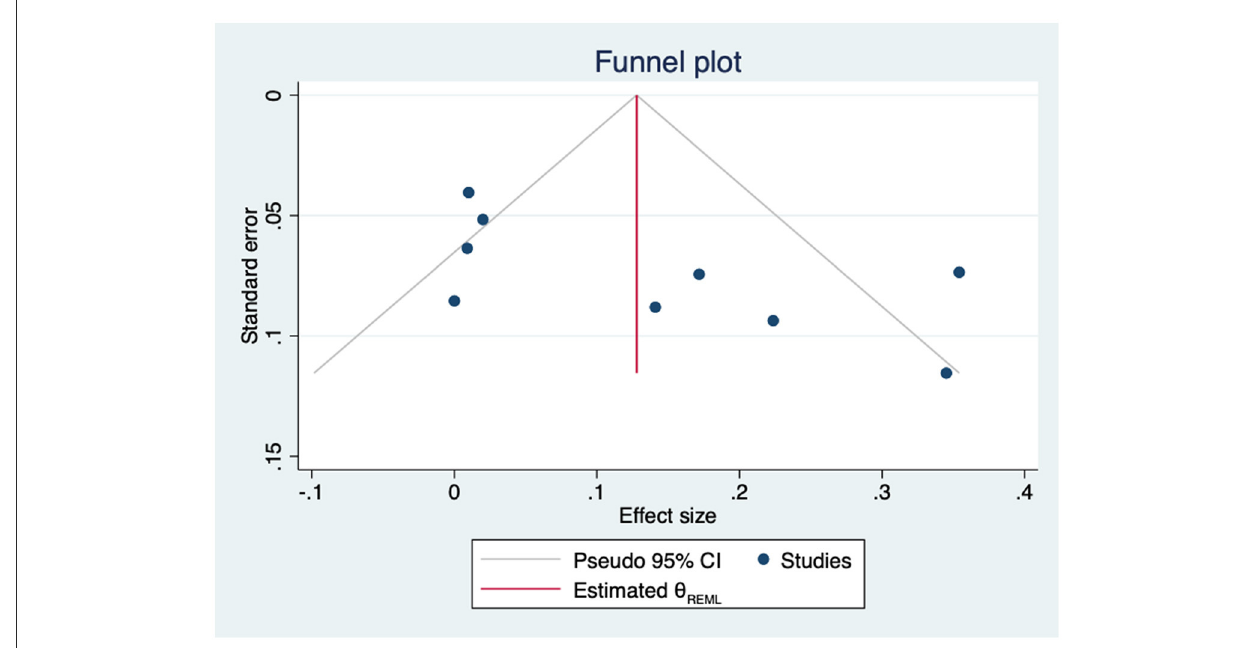
FIGURE14 Funnel plot for the association between empowerment and physical